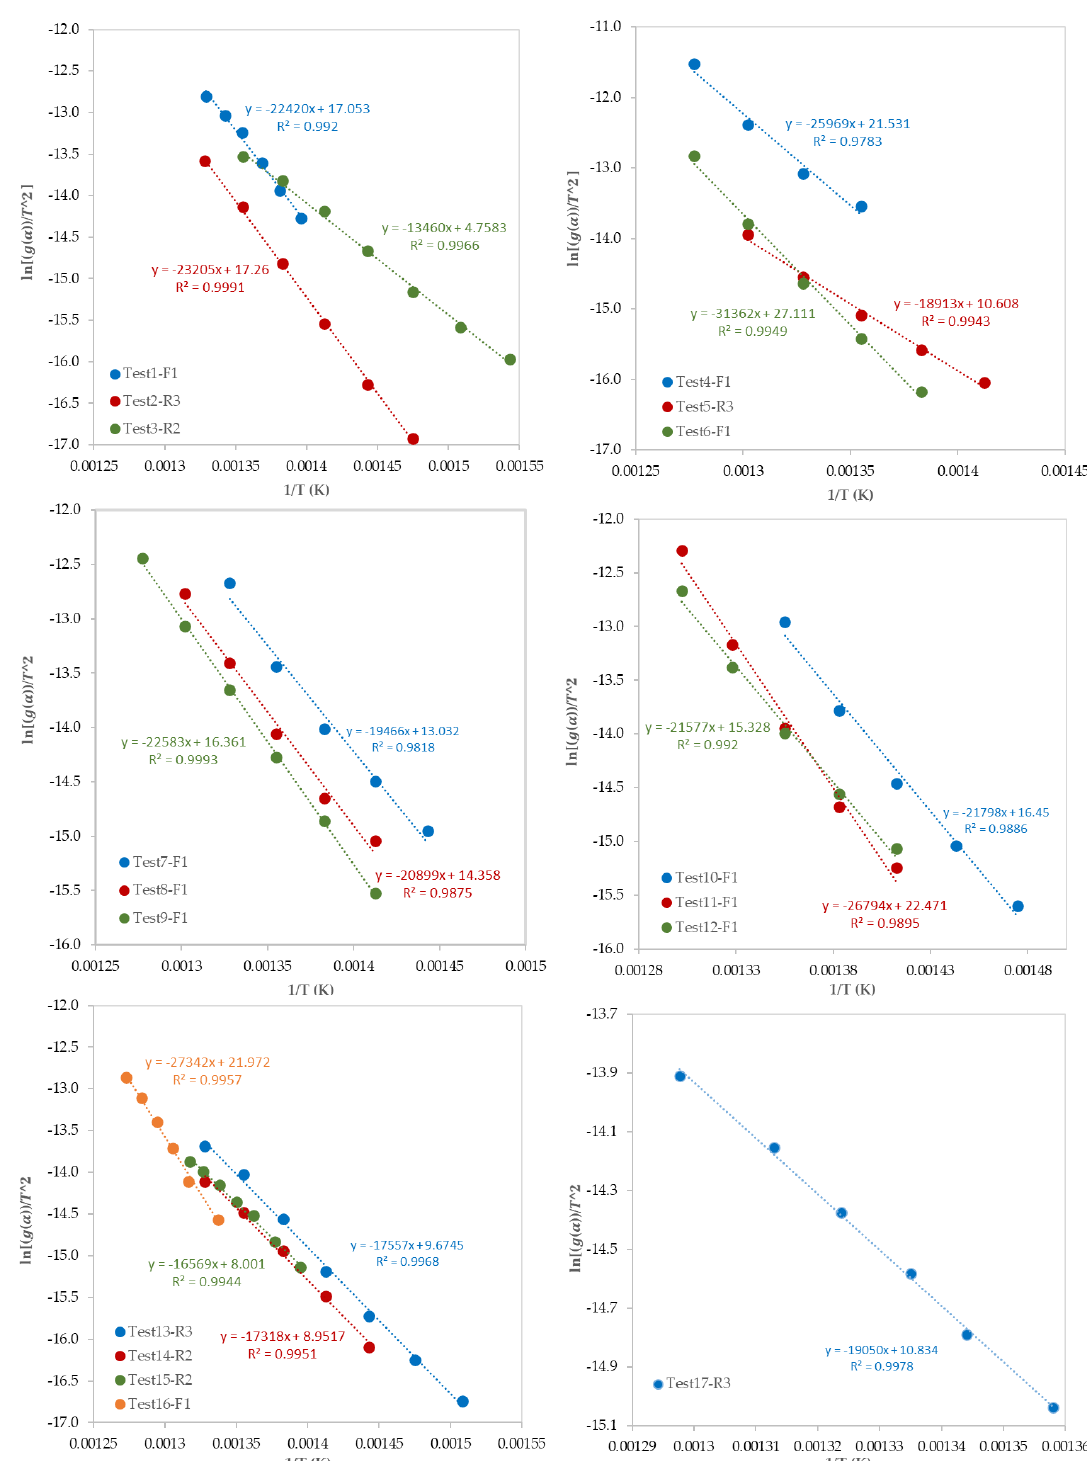
Figure 8. Plots of the Coats–Redfern model .